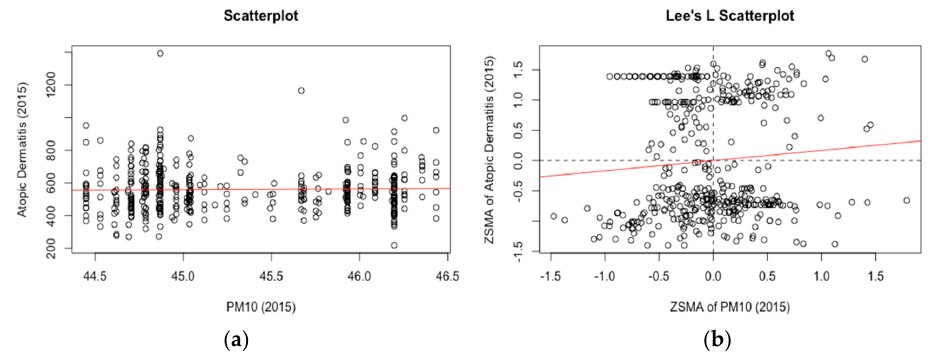
Figure 4. Scatterplots with ( a ) observed points and ( b ) Lee’s L scatterplot with Z-transformed spatial moving average illustrating association between PM 10 and atopic dermatitis (2015).